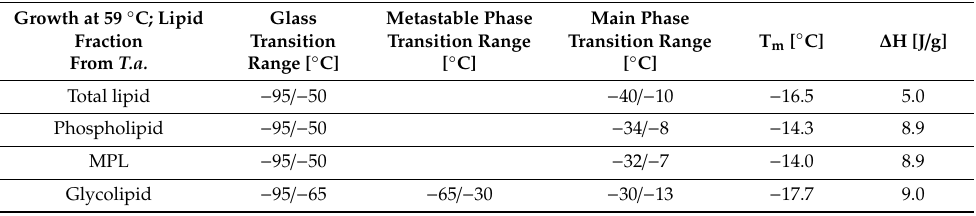
Table 2. Phase transitions of lipid fractions from Thermoplasma acidophilum. Growth at 59 ◦ C; Lipid Fraction